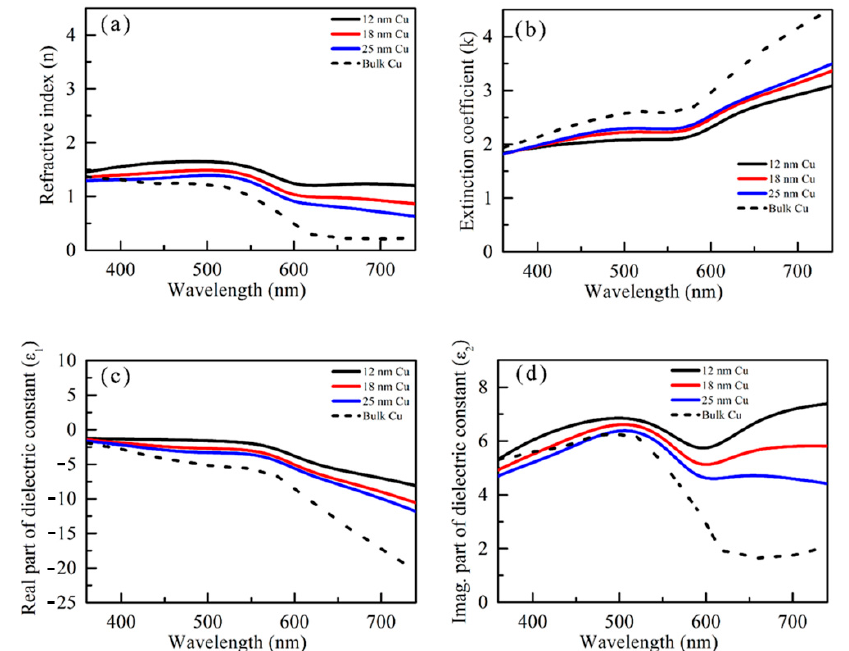
Figure 3. ( a ) The refractive indices (n), ( b ) the extinction coefficients (k), ( c ) the real ( 𝜀 (cid:2869) ), and ( d ) imaginary ( 𝜀 (cid:2869) ) parts of the dielectric constants of 12 nm, 18 nm, and 25 nm Cu film measured by ellipsometry method. These values are also compared with refractive indices and dielectric func- tions of bulk